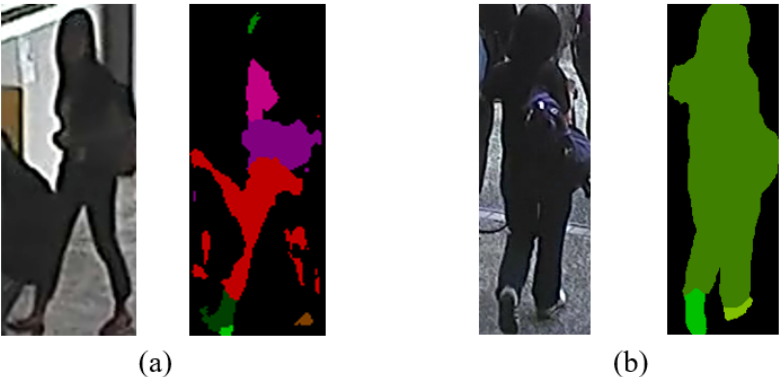
Figure 4. Parsing errors: ( a ) incorrect parsing and labeling of subregions, ( b ) overall correct parsing but most subregions are mislabeled as